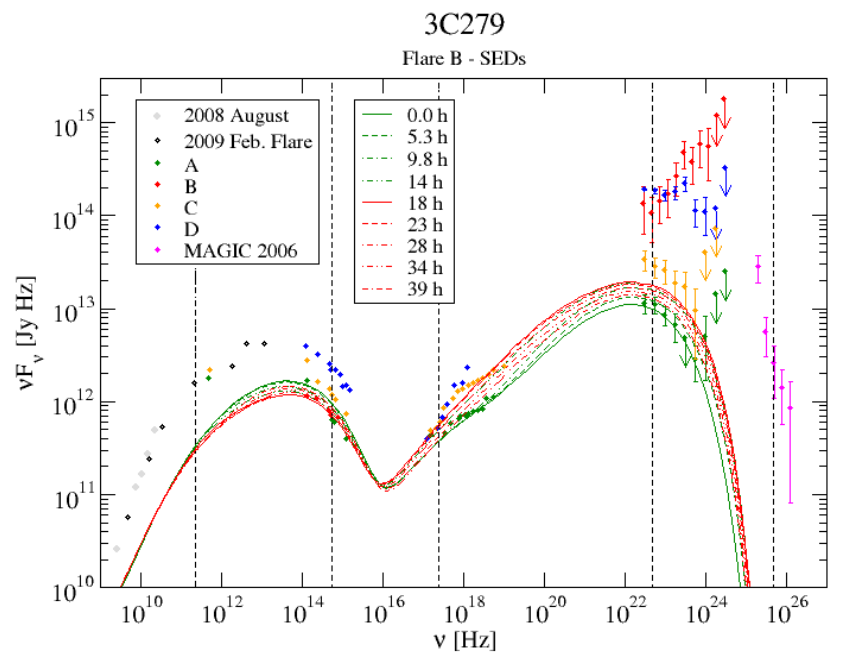
Figure 1. Spectral energy distributions (SEDs) of 3C279 in 2013–2014, from [36], along with snap-shot model SEDs from the shock-in-jet synchrotron-mirror model. The dashed vertical lines indicate the frequencies at which light curves and hardness-intensity relations were extracted. The legend follows the nomenclature of different periods from Hayashida et al. (2015) [36].